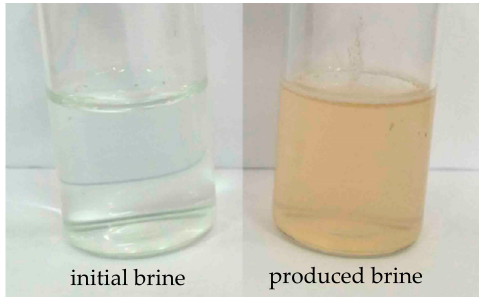
Figure 12. Initial brine and produced brine after CO 2 -WAG fl ooding